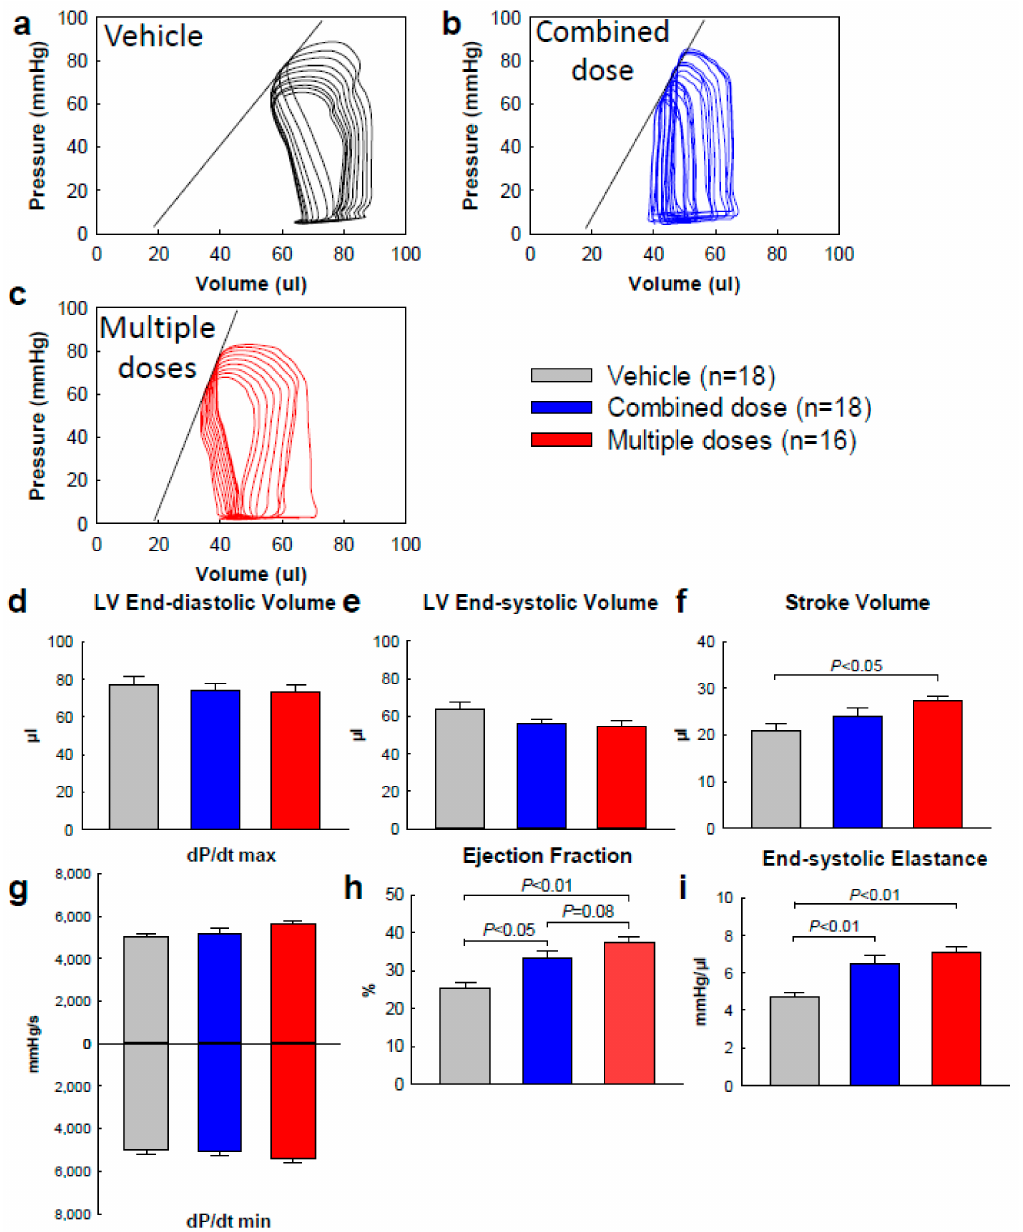
Figure 3. Hemodynamic assessment of global cardiac function ( n = 16~18/group). Invasive hemodynamic studies were performed with a finest 1F Millar conductance catheter at the end of the study. ( a – c ) Representative pressure-volume loops recorded during preload manipulation by brief inferior vena cava occlusions. ( d ) LV end-diastolic volume. ( e ) LV end-systolic volume. ( f ) LV stroke volume. ( g ) LV pressure dP/dt maximum and dP/dt minimum. ( h ) LVEF. ( i ) LV end-systolic elastance. All data are represented as the mean ±